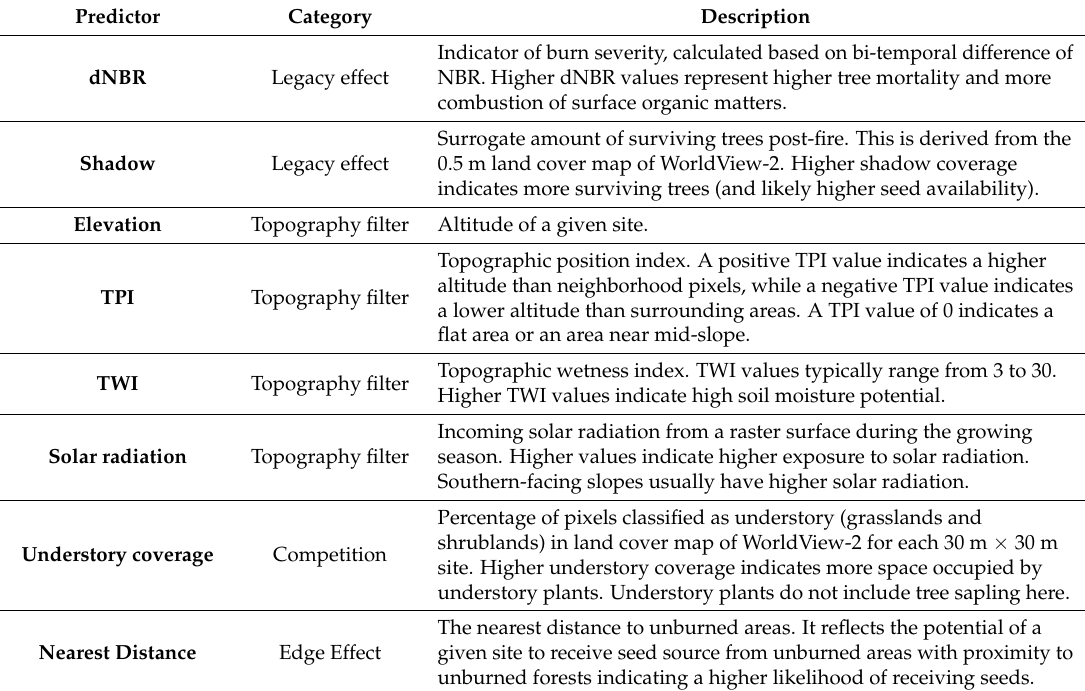
Table 3. Description of predictors used in random forest